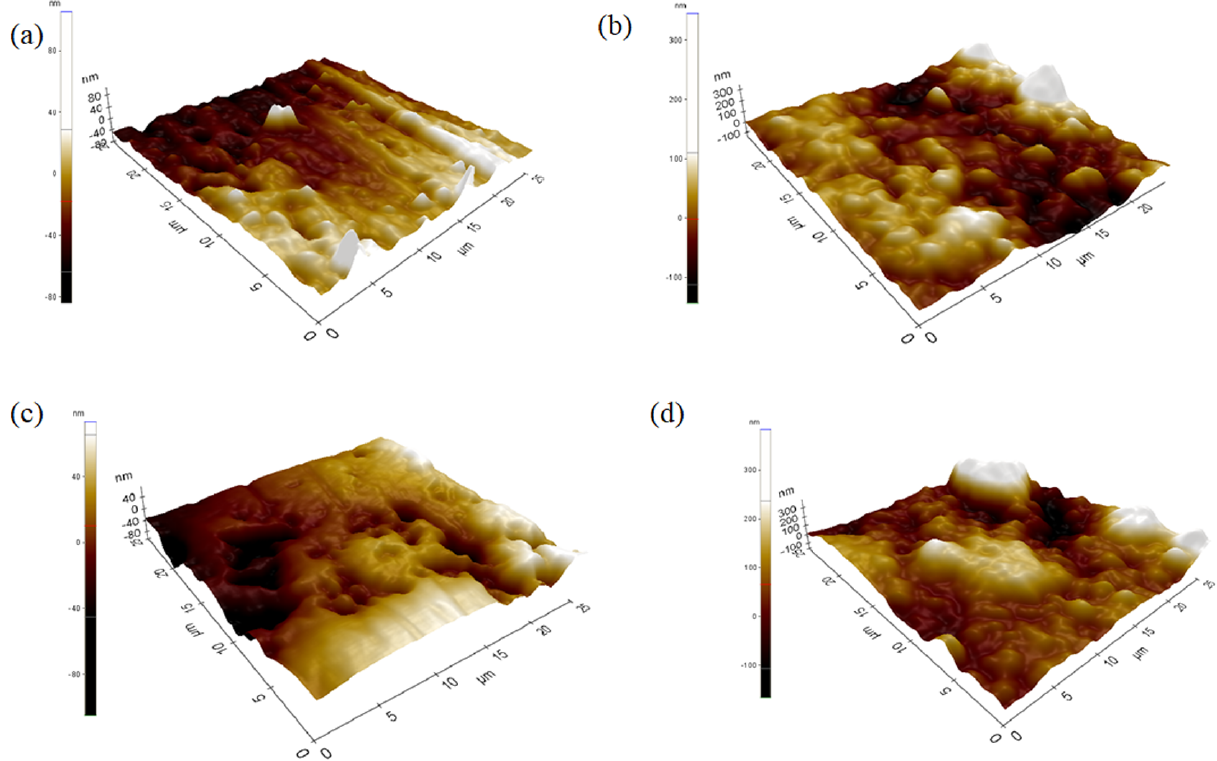
Figure 2: AFM microphotographs of all accelerating aged samples: (a)reference, (b) 2.5 h, (c) 5 h, (d) re-heat treatment